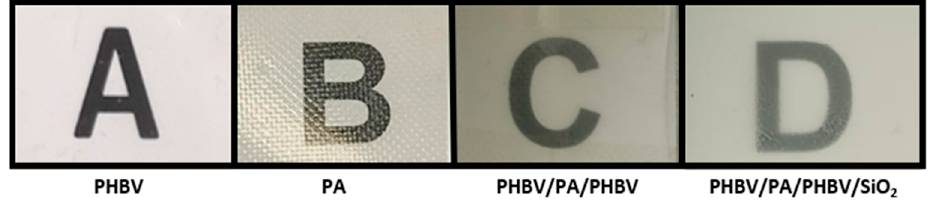
Figure 5. Visual aspect of the electrospun films of: ( A ) PHBV monolayer; ( B ) PA1010/1014 monolayer; ( C ) PHBV/PA1010/1014/PHBV multilayer; and ( D ) PHBV/PA1010/1014/PHBV/SiO 2 multilayer. Table 4. Transparency data of the mono- and multilayer films of PHBV, PA1010/1014, and SiO 2 microparticles.